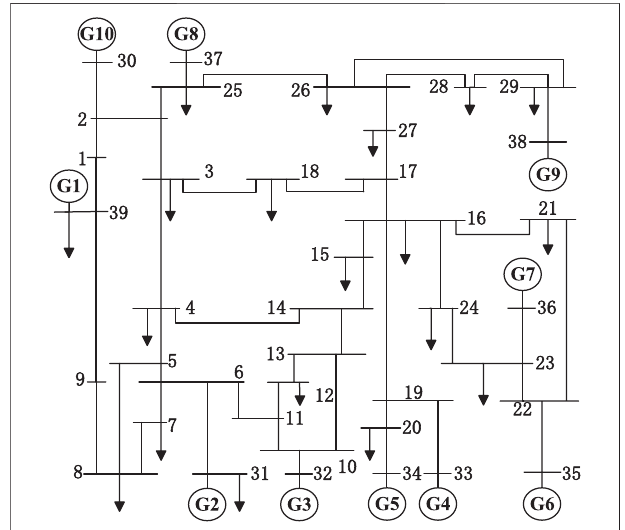
FIGURE 4 | IEEE 39-node